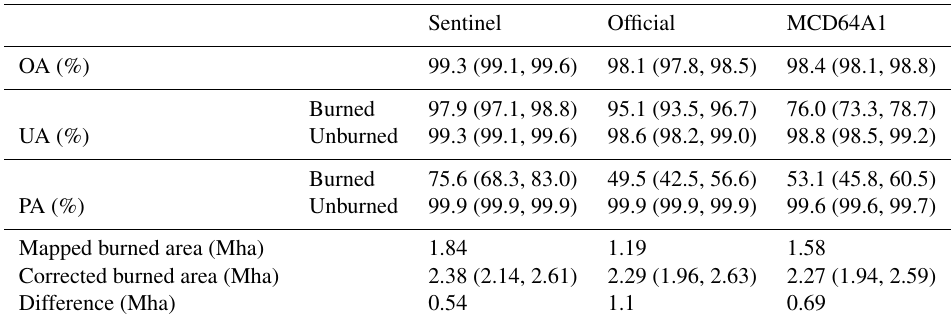
Figure 5. The 2019 burned areas (red) for Indonesia (grey area) derived using a time series of the atmospherically corrected surface re- flectance multispectral images (level 2A product) taken by the Sentinel-2A and B satellites. The spatial resolution of this map is 20m × 20m, and the minimum mapping unit is 6.25ha. The officially recognised peatland extent is shown with the darkest shade of grey. A provincial breakdown of burned areas according to our map estimates and those of the official and the MCD64A1 products is given in Fig. S5. Table 2. Accuracy assessment of each of the three burned-area maps performed in seven Indonesian provinces (87.60Mha) targeted for peatland restoration. The accuracy metrics were estimated with an initial total of 1298 points randomly distributed using stratified sampling. The reported metrics are (1) the overall accuracy (OA), the user accuracy (UA), and the producer accuracy (PA) with their 95% confidence intervals and (2) the mapped burned area and the corrected burned area with their 95% confidence